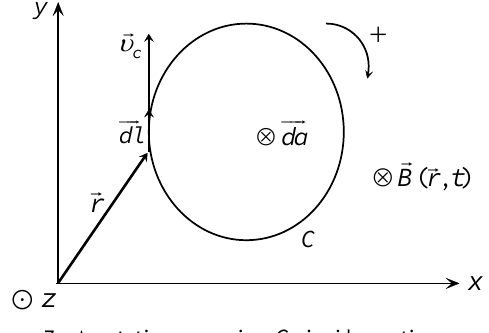
Figure 7: A stationary wire C inside a time-varying magnetic